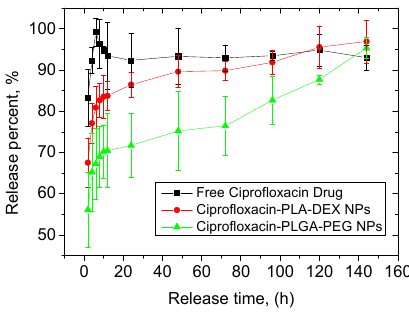
Figure 3. The cumulative release profiles of ciprofloxacin in vitro in simulated tear fluid (STF) at 37 °C as free drugs by PLA-DEX NPs and PLGA-PEG NPs. (n = 3; mean ± S.D.).